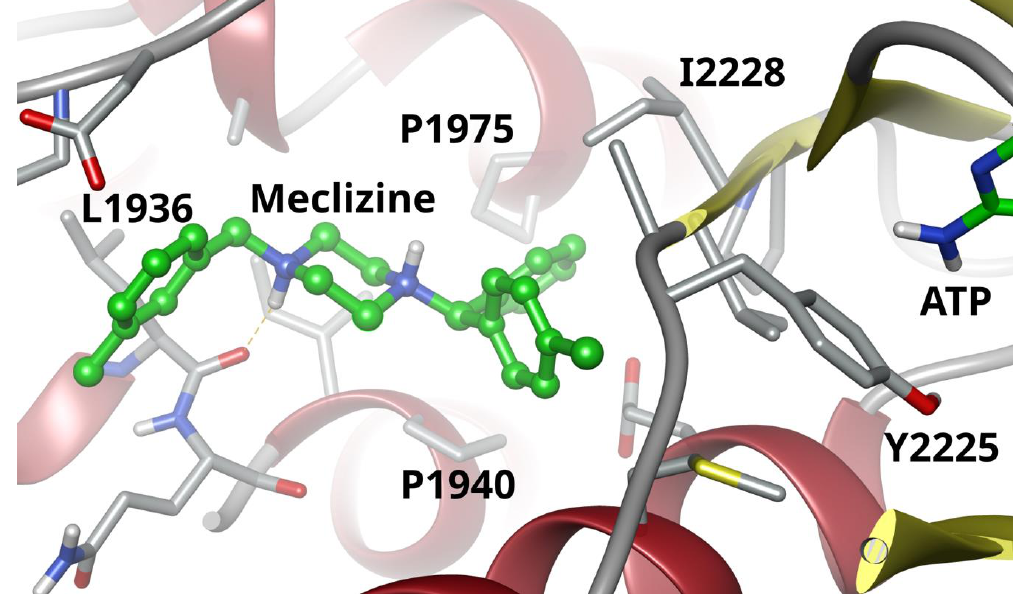
Figure A5. A pose of meclizine within the kinase domain of mTOR.